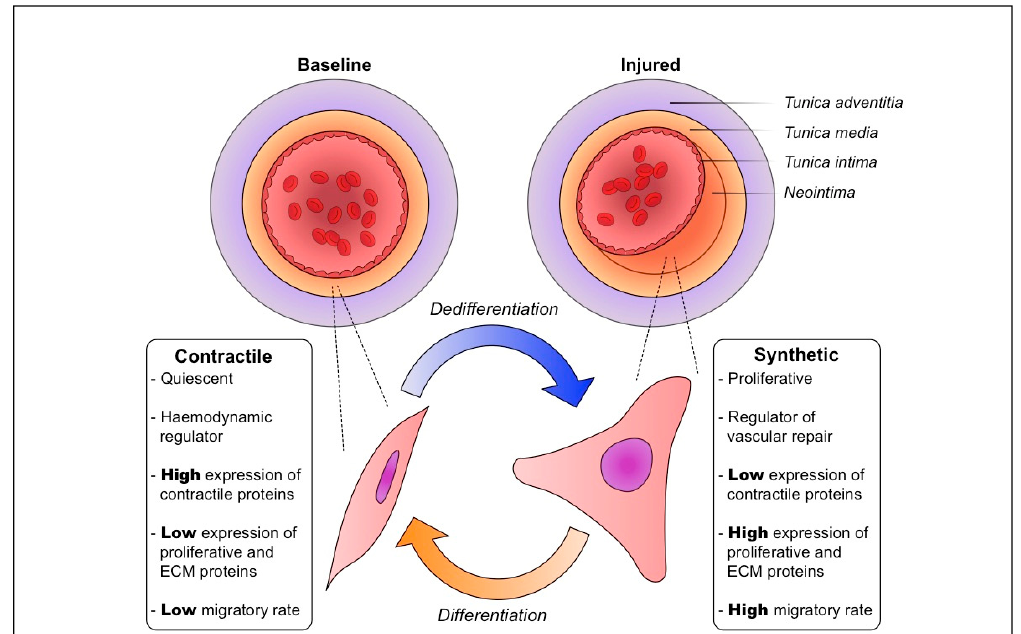
Figure 1. Physiological vascular smooth muscle cell plasticity is vital for vascular repair and homeostasis. At baseline, the tunica media of blood vessels is kept at an appropriate thickness, and vascular smooth muscle cells (VSMCs) have a quiescent, non-migratory contractile phenotype. Following vascular injury, these VSMCs are induced to dedifferentiate to a proliferative, migratory synthetic phenotype. Their growth and increased production of extracellular matrix (ECM) components result in a substantial thickening of the media and formation of a neointima. Followimg vascular repair and reestablishment of homeostasis, synthetic VSMCs are gradually induced to differentiate back to the contractile phenotype.